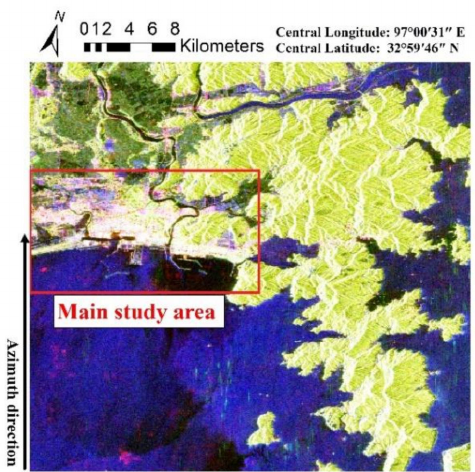
Figure 3. The Pauli RGB image of the ALOS-1 PolSAR data in Ishinomaki